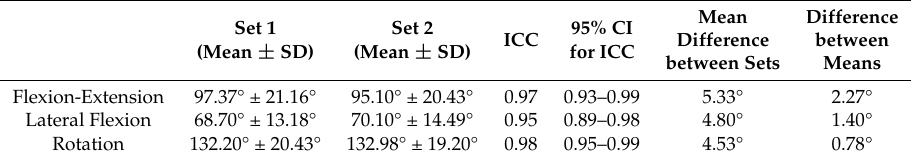
Left Rotation Table 3. Results for the two sets of motions performed with the second sensor located in C7 considering full movements.